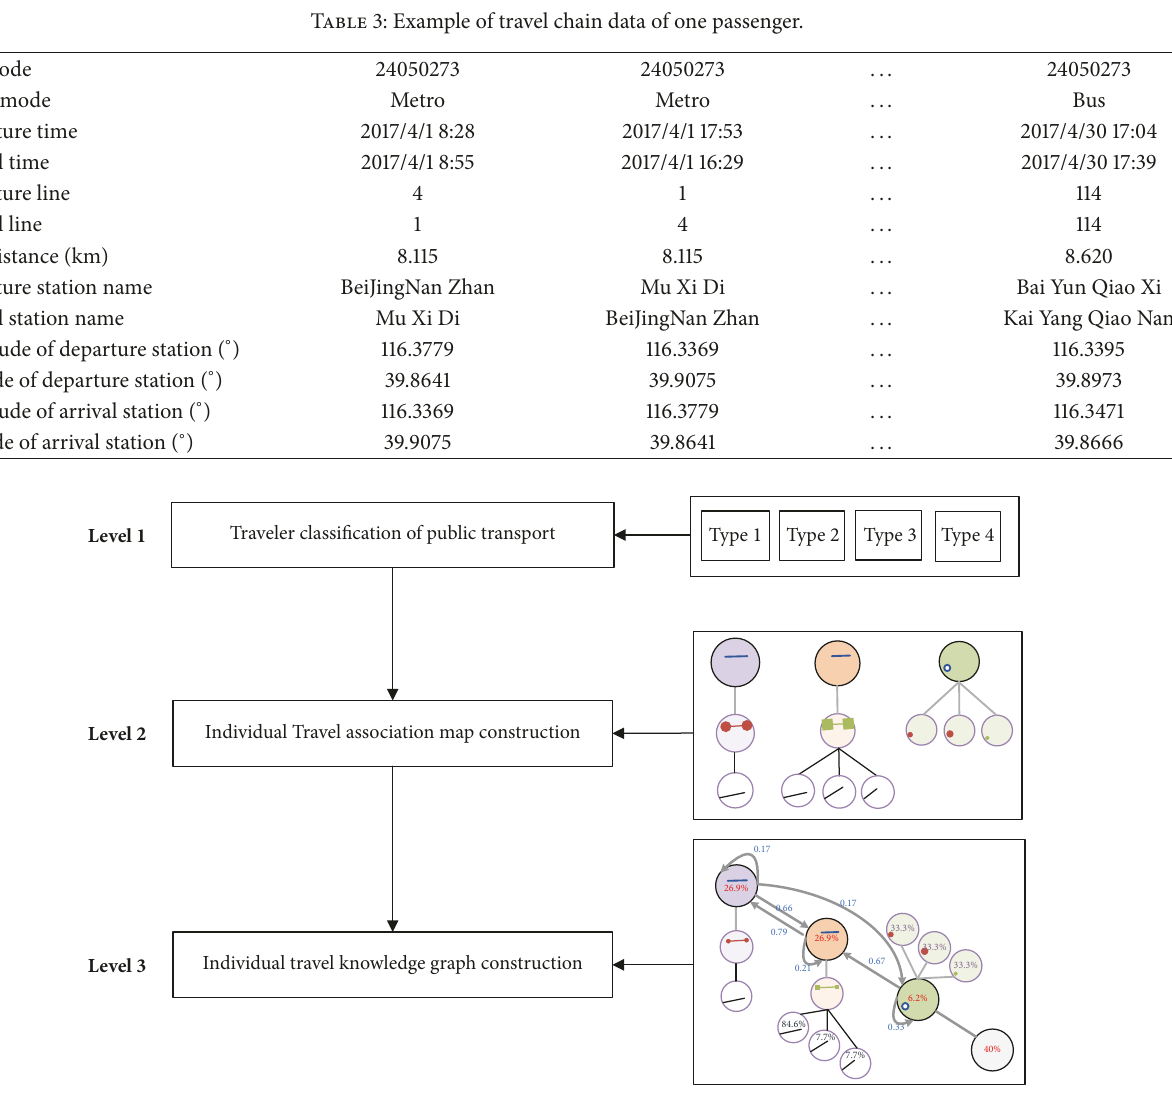
Figure 1: The flowchart of individual travel behavior graph